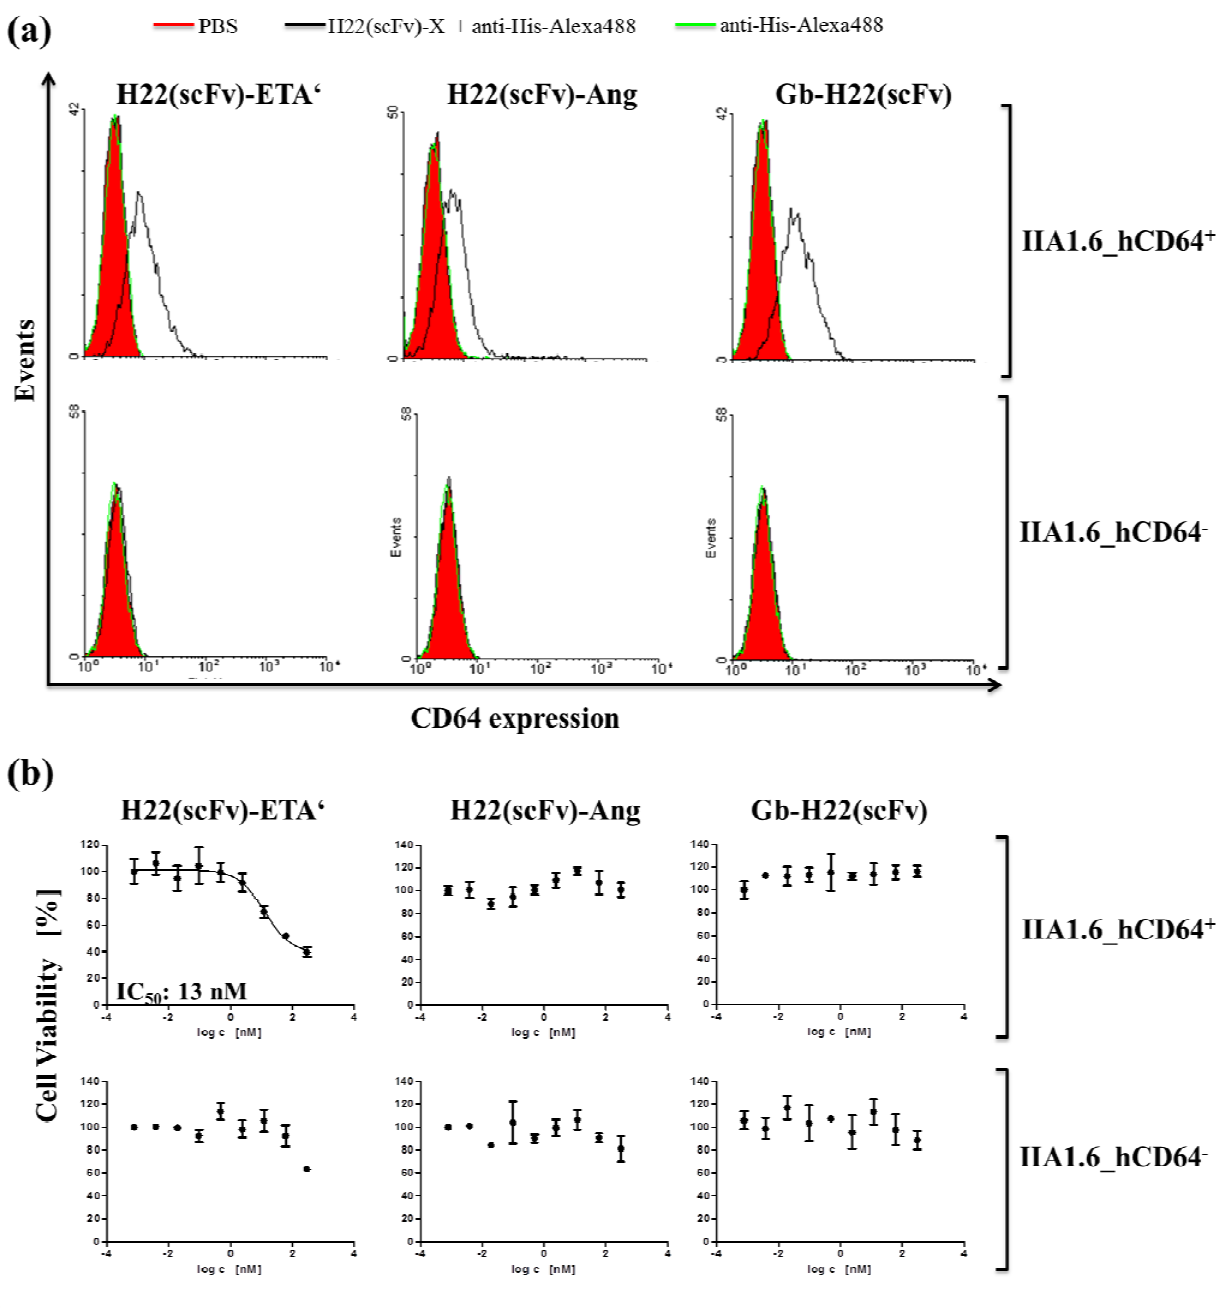
Figure 1. Binding ( a ) and cellular cytotoxicity ( b ) of H22(scFv)-based fusion proteins to the murine cell line IIA1.6. Cell binding activity of 1 µM recombinant protein was analyzed by flow cytometry. Detection was performed using an anti-Penta-His-Alexa Fluor 488 antibody. Cellular cytotoxicity was assessed by a XTT assay. The concentration required to achieve 50% reduction of protein synthesis (IC ) relative to untreated control 50 cells was calculated using GraphPad Prism. All experiments were carried out in